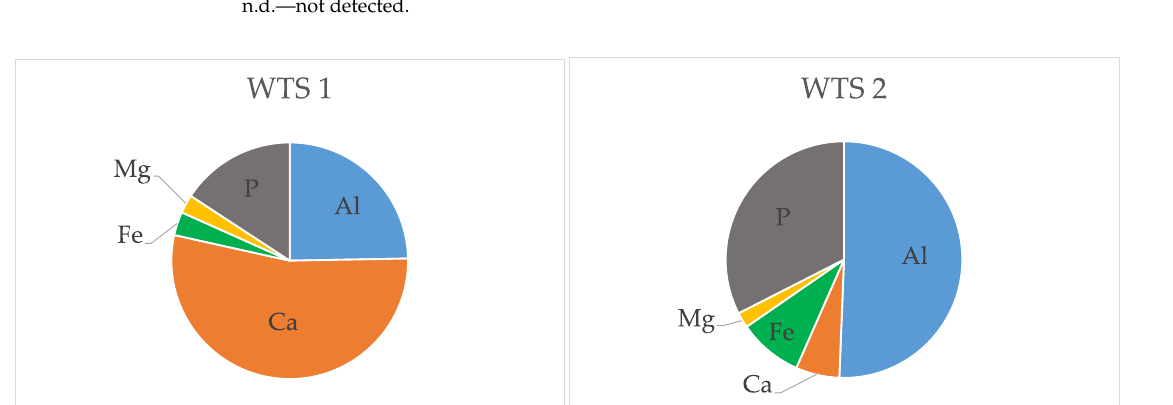
Figure 1. Mineral composition of drinking water treatment sludge (WTS) samples in w / w % for the major elements.